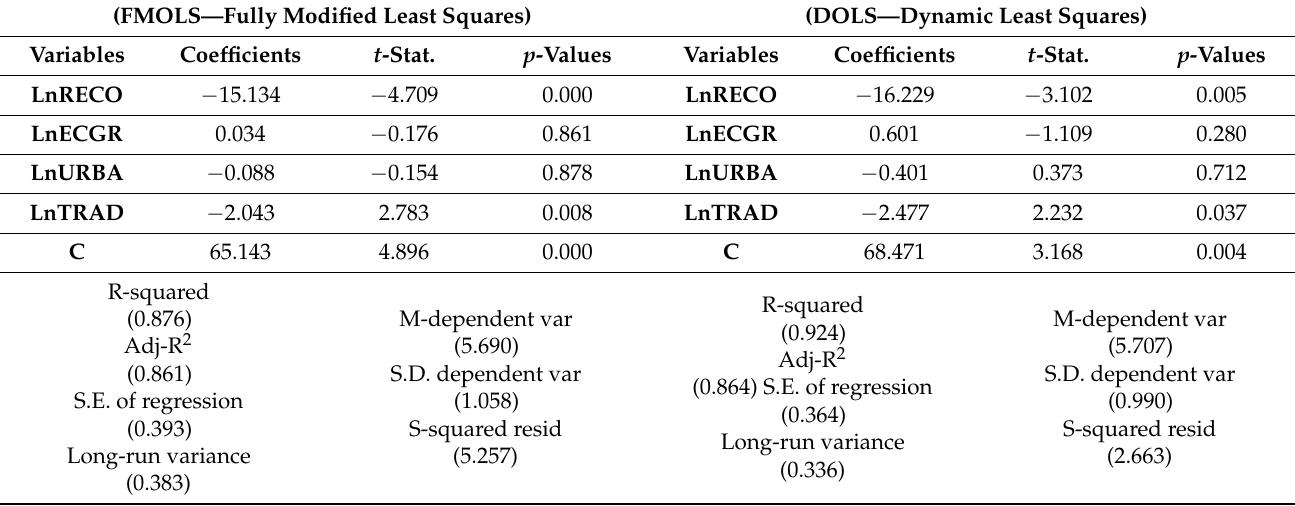
Table 10. Outcomes of the cointegration regression analysis.